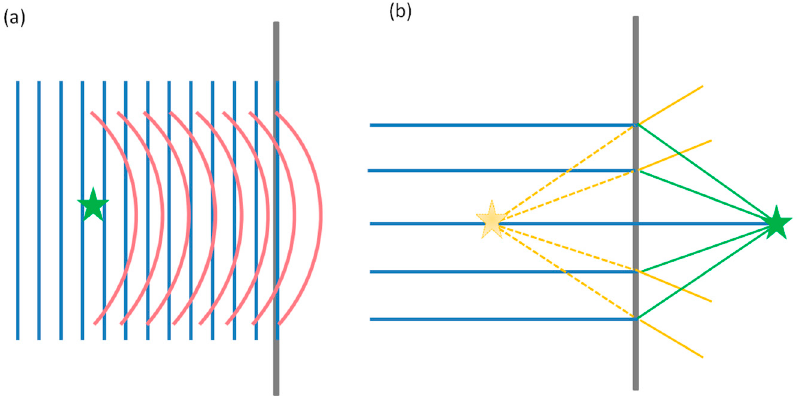
Figure 3. Sketch of ( a ) writing and ( b ) reading of in-line holography. The blue lines represent the reference wave, and the red lines represent the object wave. The green (solid) and yellow lines (dotted) represent the diffracted reference wave that forms the real (green) and virtual (yellow) images.